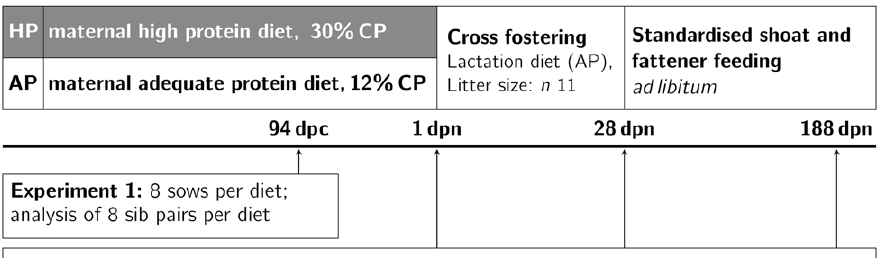
Figure 3. Experimental design.